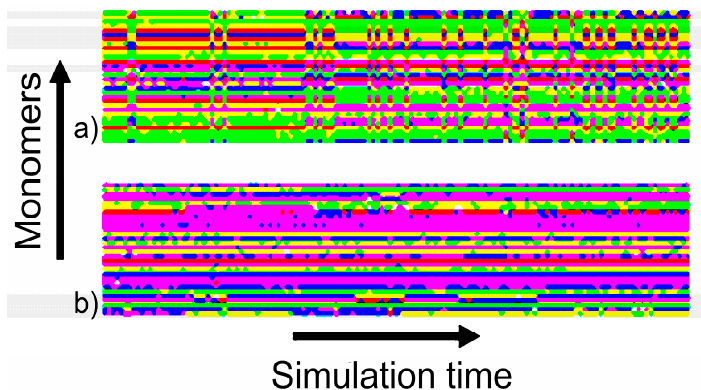
Figure 7. The change of the dihedral angles of the main chain in each monomer in a typical section of a trajectory obtained from ( a ) HRE simulation and ( b ) MD simulation. Each pixel illustrates the conformation of one monomer during 100 ps. The colors indicate the combination of ϕ and ψ dihedral angles corresponding to specific secondary structures (see Figure S2): PPII helix—pink, 2.5 10 helix—blue, 3 10 helix—yellow, right-handed α helix—green, left-handed α helix—red.